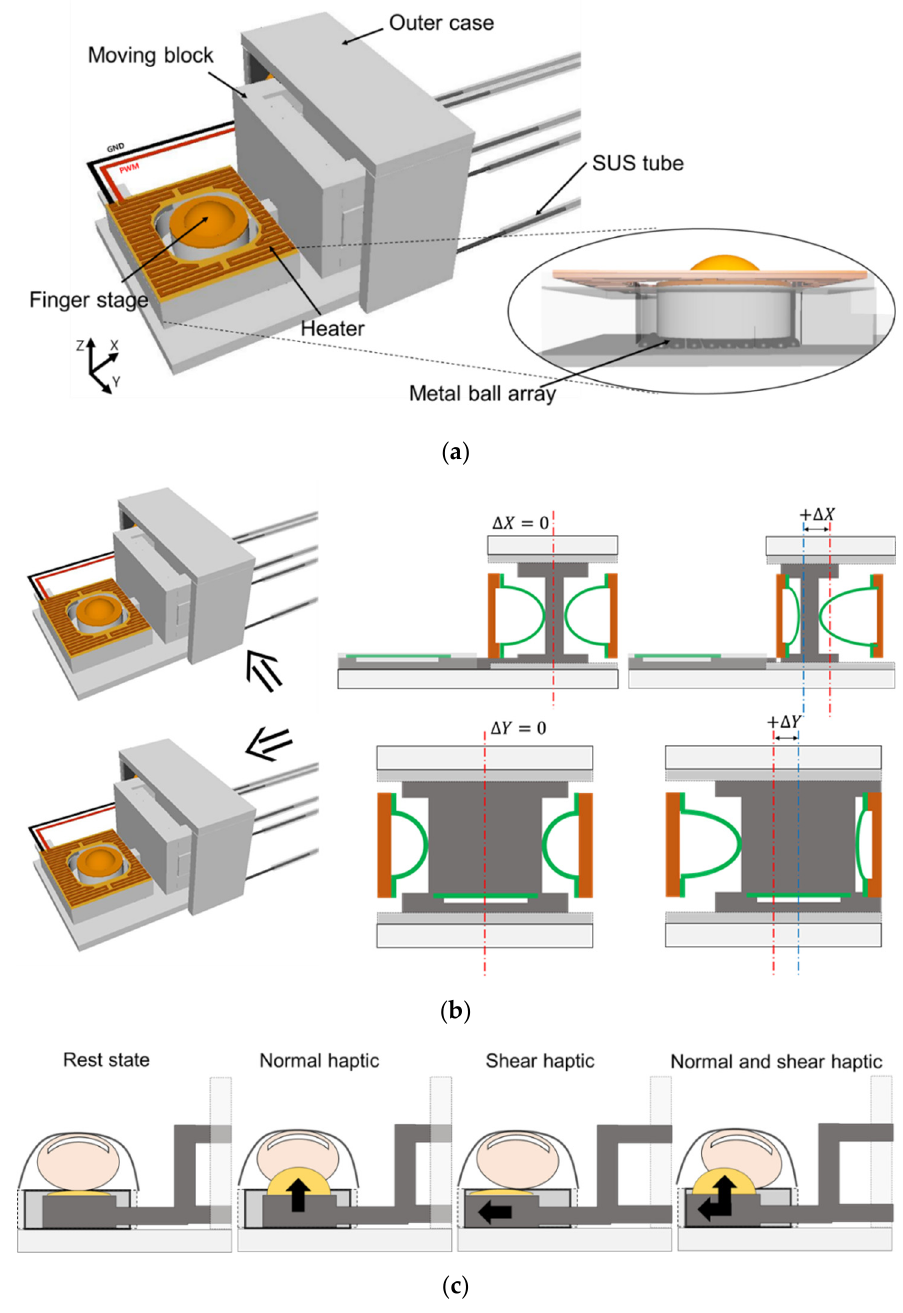
Figure 1. Conceptual view of a three-axis pneumatic haptic display capable of expressing thermal sensation (excluding rubber strap for finger fixation). ( a ) Proposed device. ( b ) Side and rear view during operation. ( c ) Finger on the device and its operation for normal and shear haptics.